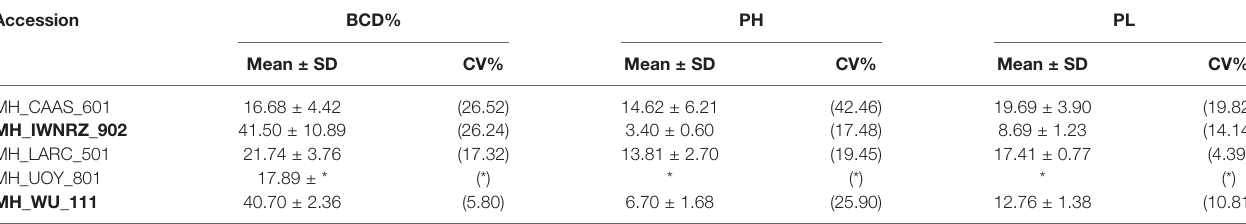
TABLE 5 | Summary statistics of hemp accessions with extreme phenotypes for three fi ber traits.